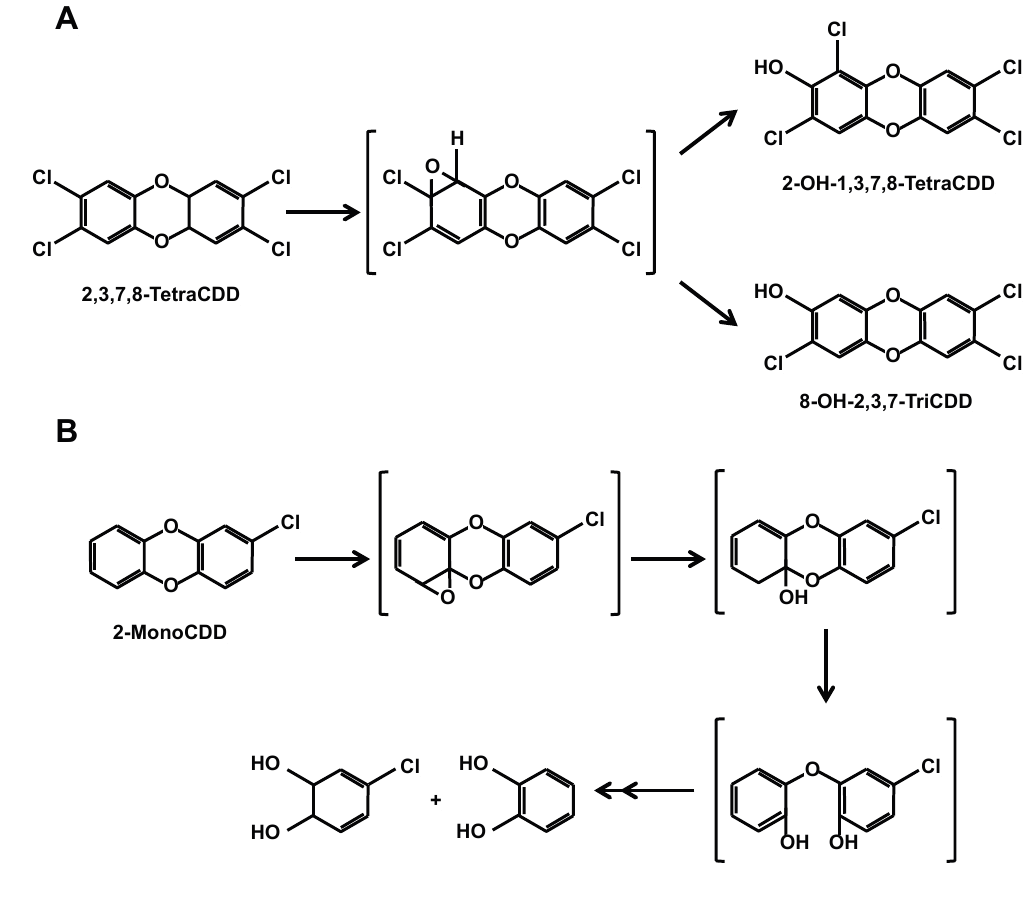
Figure 3. Metabolic pathways for 2,3,7,8-tetraCDD ( A ) and 2-monoCDD ( B ) involving